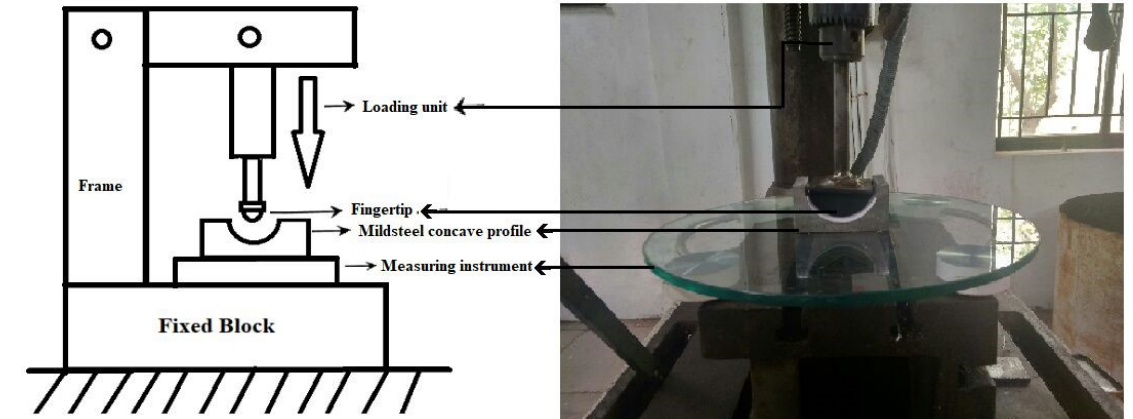
Figure 2: Experimental Setup.